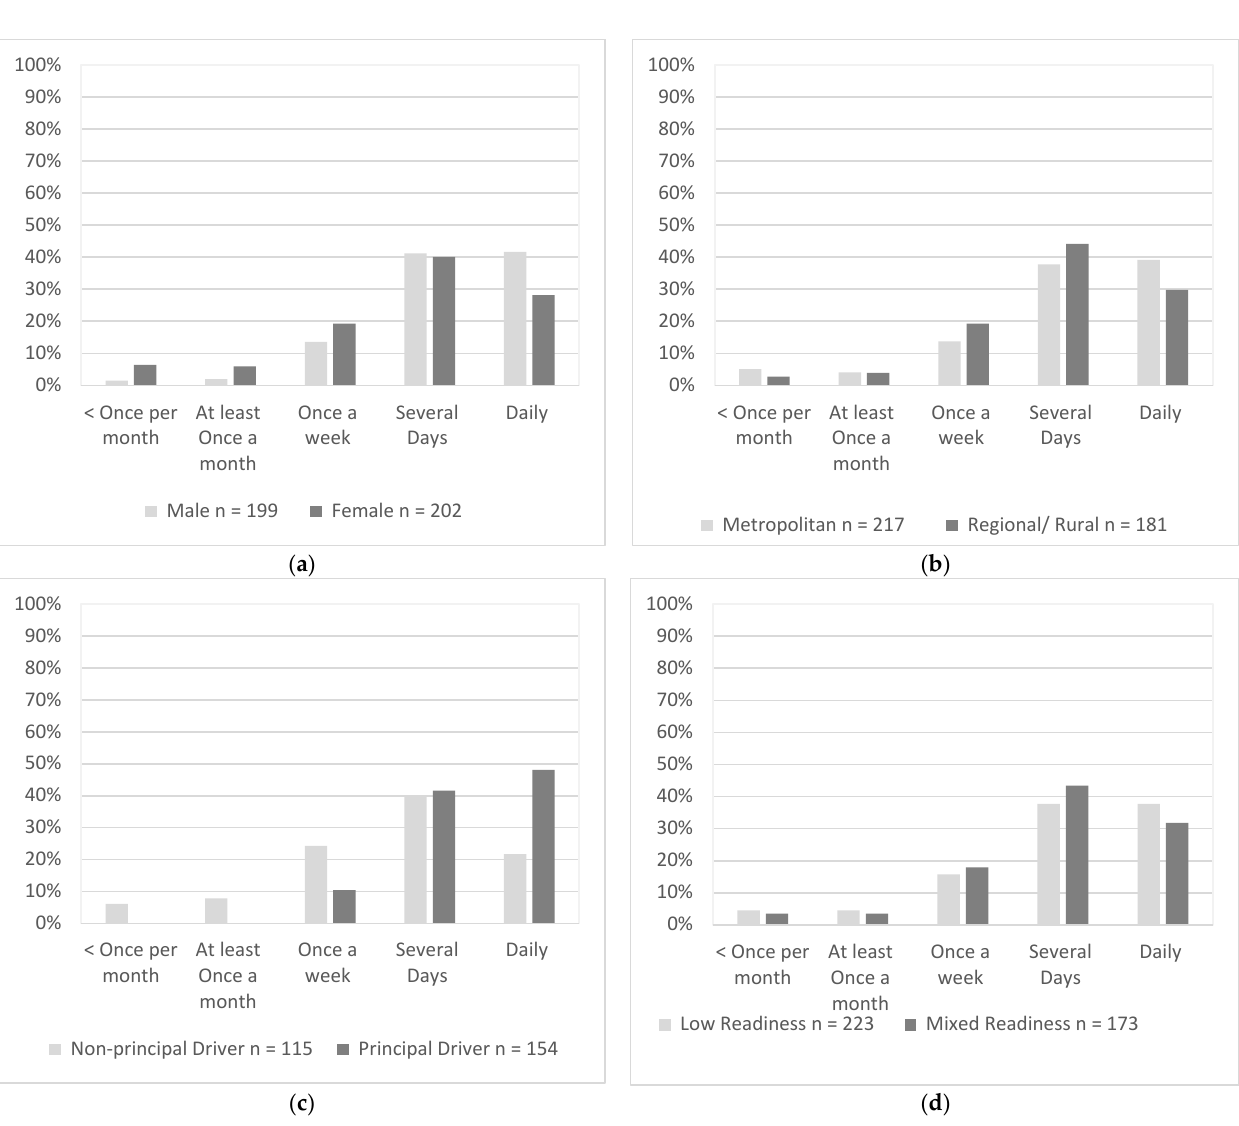
Figure 3. Driving Frequency as endorsed by participants in each group; ( a ) Gender, ( b ) Residential Area, ( c ) Driving Roles, ( d ) Readiness. Percentages represented proportions of participants in each group who endorsed that option.